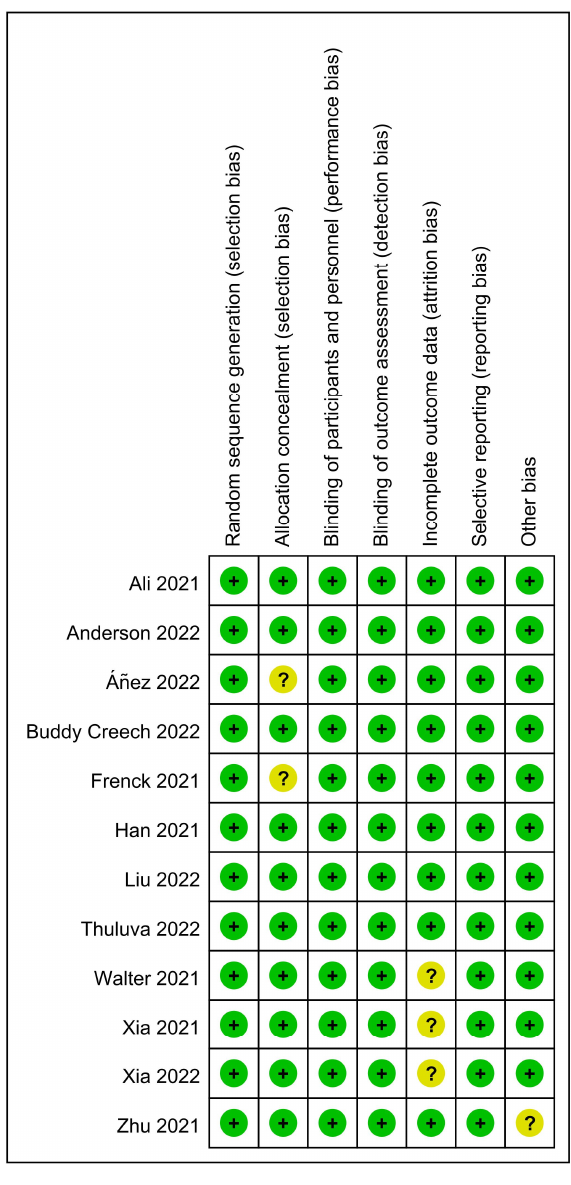
Figure 3. Risk of bias summary for included RCTs (the green color and special symbol “+” are represented a low risk of bias, and the yellow color and special symbol “?” are represented an unclear risk of bias). Table 2. The characteristics of the included studies.